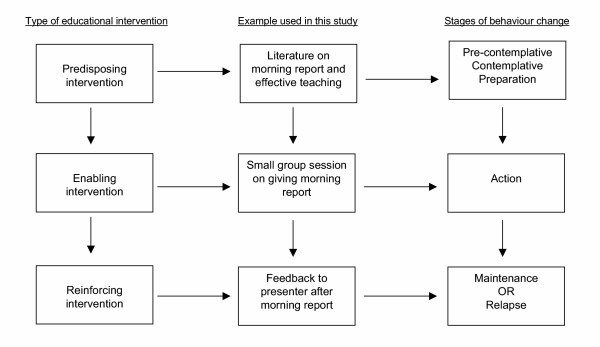
Types of educational interventions designed to change behaviour.